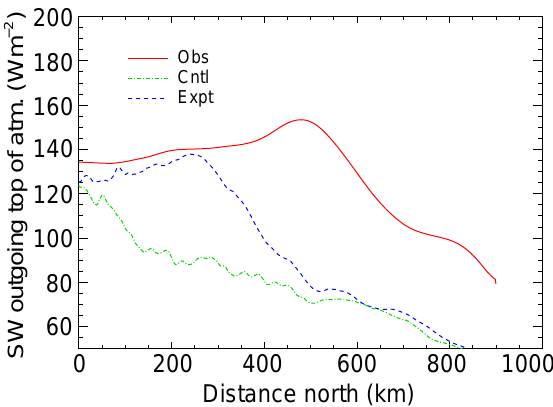
Fig. 2. Top-of-atmosphere reflected shortwave along a meridional flight track from a cold-air outbreak case within the CONSTRAIN field campaign. The solid line (Obs) are aircraft observations made at about 11:00 UTC on 31 January 2010; the dotted line (Cntrl) is a 17 h forecast from the 1.5 km resolution limited area MetUM NWP configuration (UKV) valid at the same time as the observations and the dashed line (Expt) is from an equivalent UKV forecast including the shear-dominated boundary layer diagnosis.